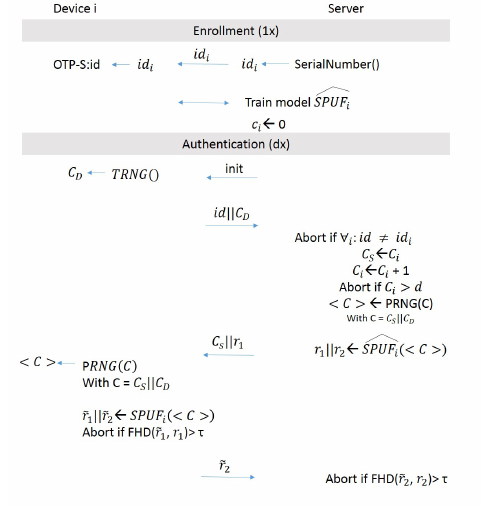
Figure 11. Lockdown protocol. Adapted from